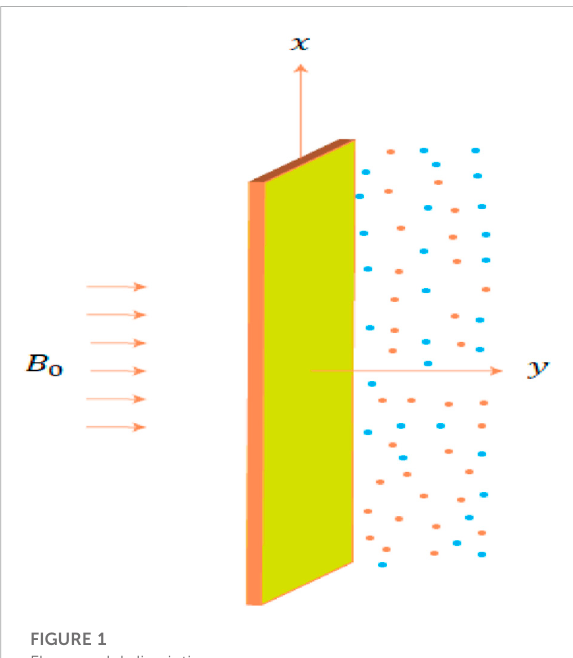
FIGURE 1 Flow model